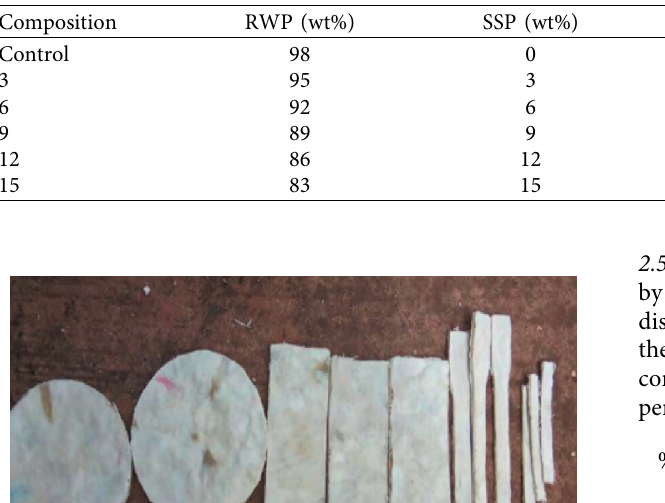
Figure 1: (a) Waste plastics, (b) snail shell, and (c) snail shell particle. Table 1: Composite composition.